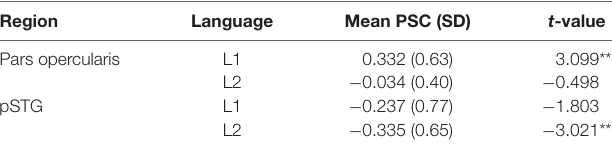
TABLE 4 | Grammaticality effect of left-lateralized syntax-specific ROIs in separate languages.